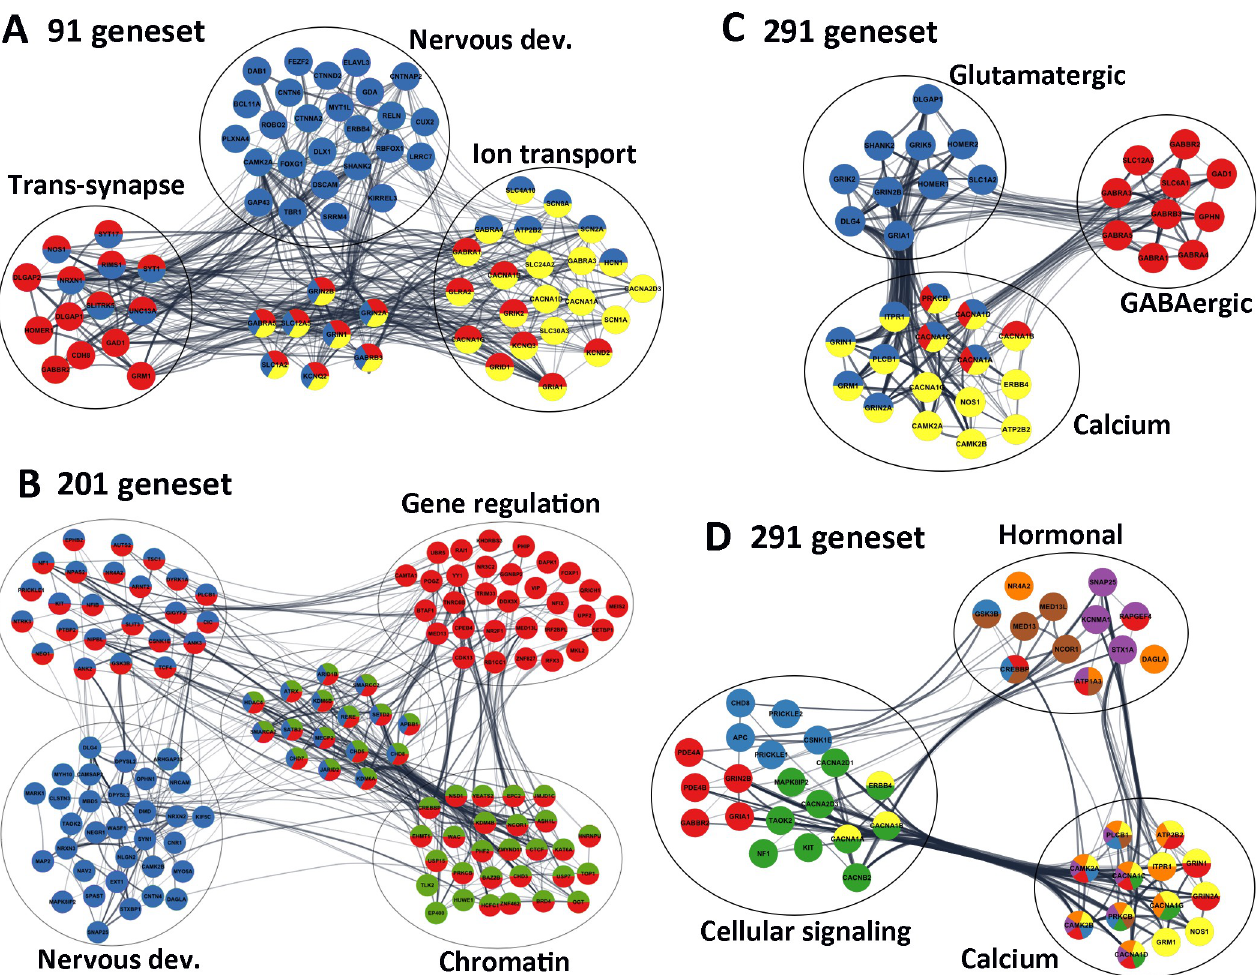
Fig 6. Significant ASD pathways. (A) Selected genes from 91 CNS geneset, highlighting that Nervous development (blue), Trans-synapses (red) and Ion transmembrane transportation (yellow) are the most enriched pathways. (B) Selected genes highlighted from the 200 CNS+PT geneset, demonstrating that the Nervous development (blue), the Chromatin organisation (green) and Gene regulation (red) were the among the most significant pathways. (C) Glutamatergic/ GABAergic synapses, (D) Cell signalling and Hormonal secretion pathways from the combined 291 genes all linked to calcium signalling, suggesting that Calcium signalling is the most interconnected pathways linking the ASD signalling pathways. Edges represent combined gene score, node colours represent selected GO terms (A-B) and KEGG pathways (C,D) The colours for 3D correspond to the following; Yellow-Calcium Signalling, Green -MAPK Signalling, Red -cAMP signalling, Blue—Wnt Signalling, Brown—thyroid signalling, purple–Insulin Signalling, Orange–Aldosterone Synthesis and Secretion.